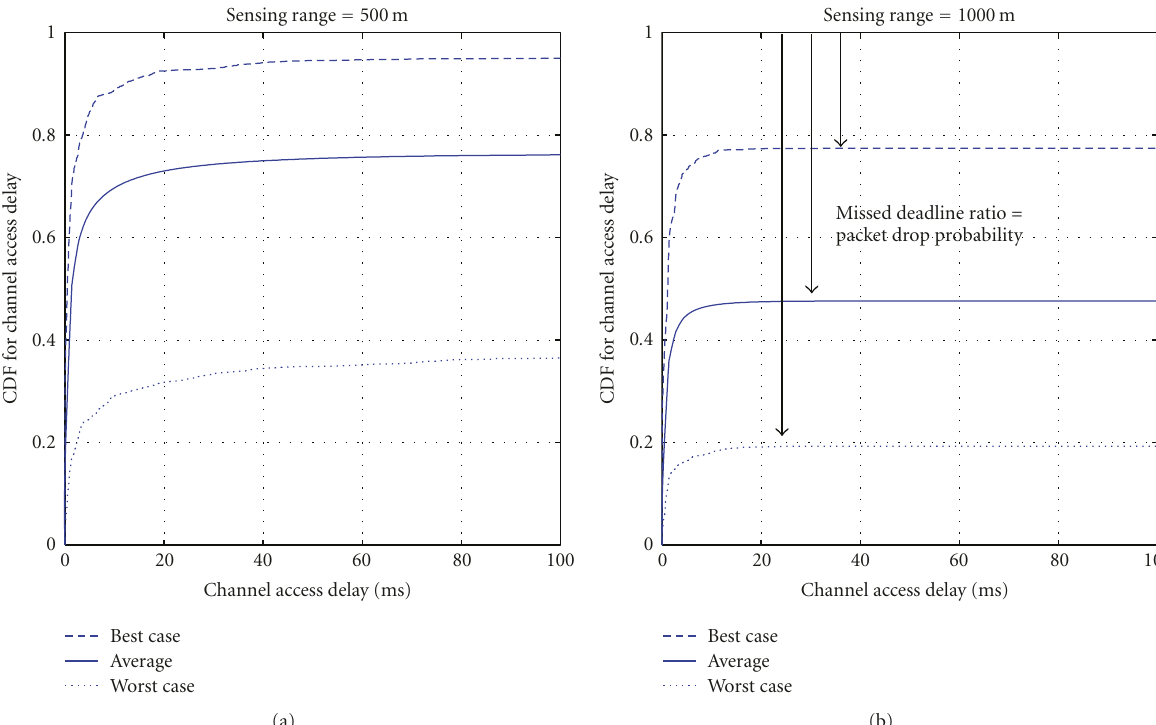
Figure 5: Cumulative distribution function of channel access delay, in a highway scenario with 10 lanes, 500 byte packets, 10Hz heartbeat. (a) Sensing range of 500 meters and (b) sensing range of 1000